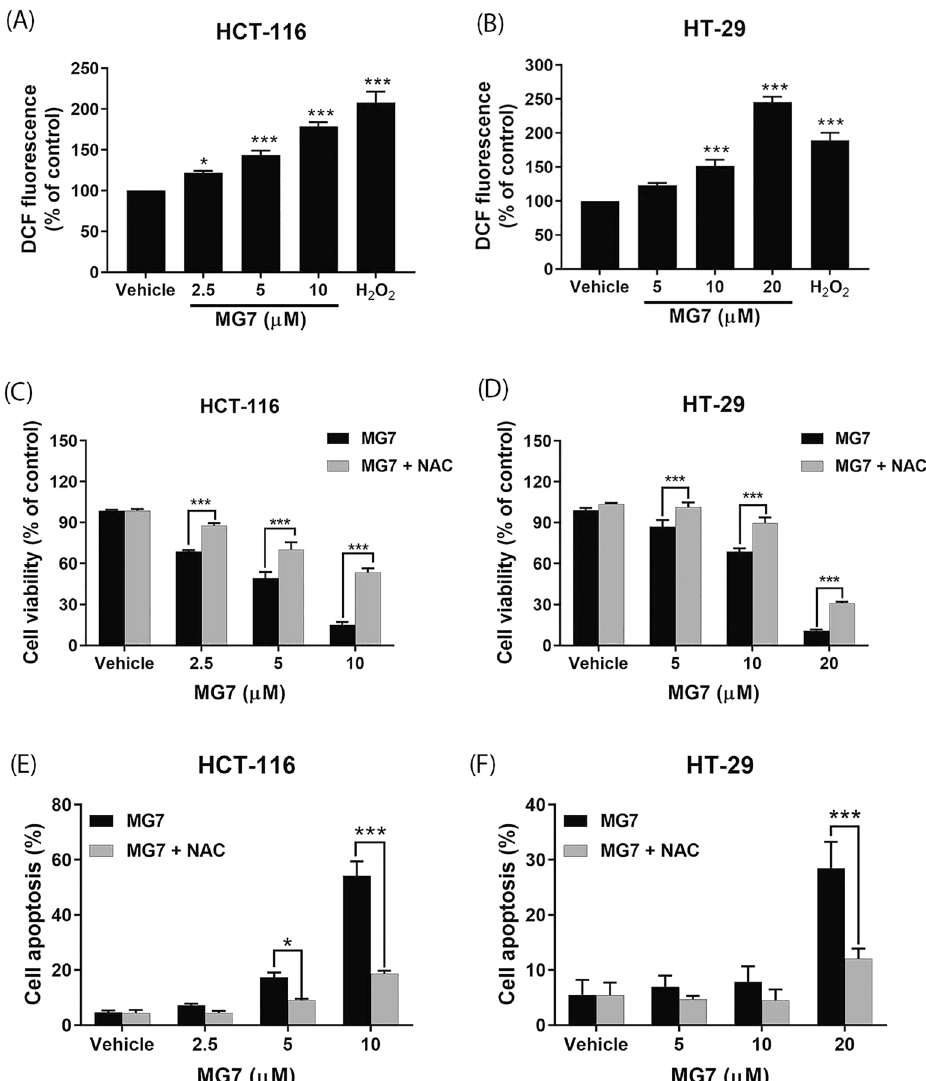
Figure 7. Roles of ROS on cytotoxic and apoptosis-inducing effects of MG7. The ROS levels in ( A ) HCT-116 and ( B ) HT-29 cells after being treated with MG7 at indicated concentrations or H 2 O 2 at 200 µM were evaluated using DCFH 2 -DA assay. The viability of ( C ) HCT-116 and ( D ) HT-29 cells and the numbers of annexin V-positive apoptotic ( E ) HCT-116 and ( F ) HT-29 cells after being treated with MG with or without NAC. * P < 0.05, ** P < 0.01 and *** P < 0.001 compared to vehicle control (0.2%